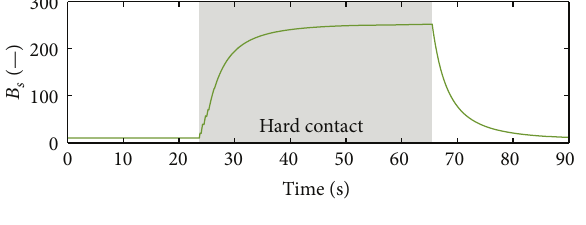
Figure 7: Evolution of 𝐵 𝑠 (𝑡) .